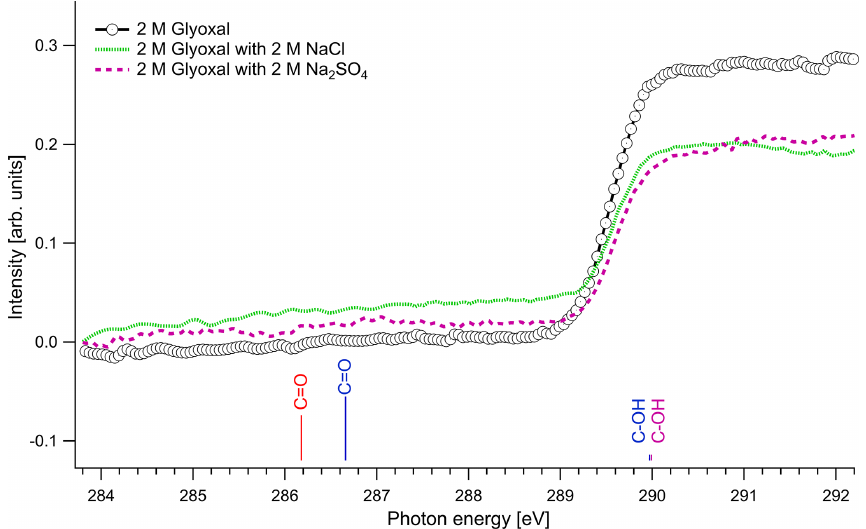
Figure 3. C K-edge spectra of glyoxal–water (2M) binary solution and 1:1 molar mixtures with NaCl and Na 2 SO 4 . The lines present the calculated C 1s → π ∗ excitation energies. The color of the lines corresponds to different hydrated species: red: unhydrated glyoxal; blue: monohydrated glyoxal; purple: dihydrated glyoxal. The calculated vertical lines have been scaled according to the calculated oscillator strengths.